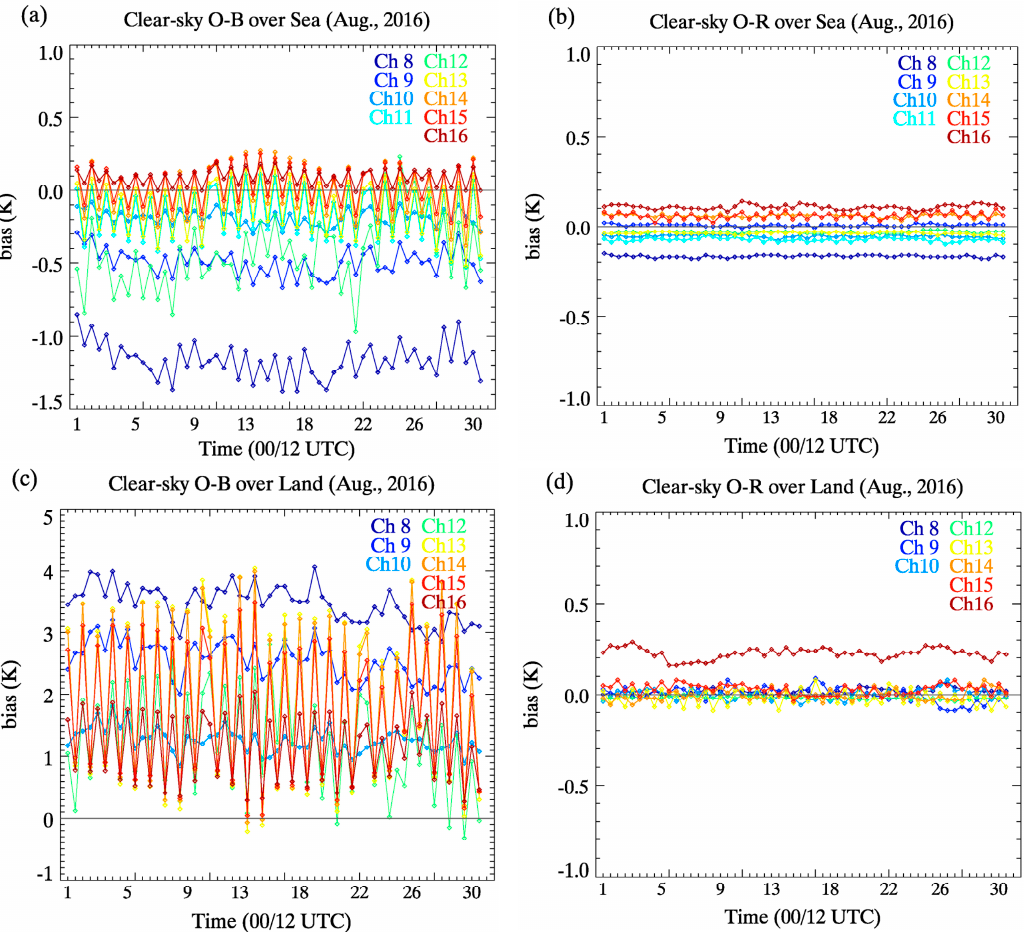
Figure 10. Time series of the background departure over the ocean ( a ) and land ( c ) and the retrieval departures over the ocean ( b ) and land ( d ) under clear-sky conditions for August 2016 (00/12